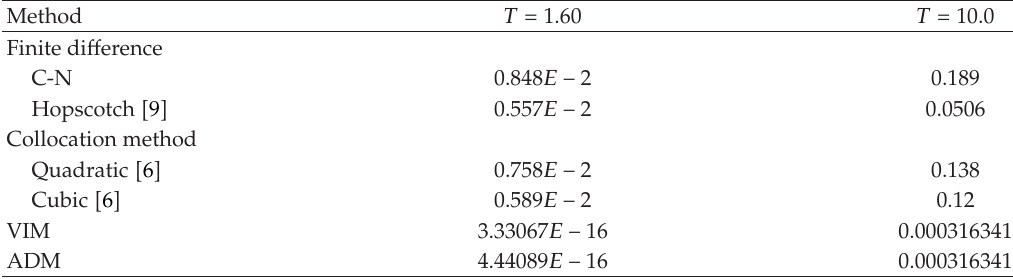
Table 4: Comparison between VIM, ADM, and other methods by maximum errors. Method T (cid:8) 1 .